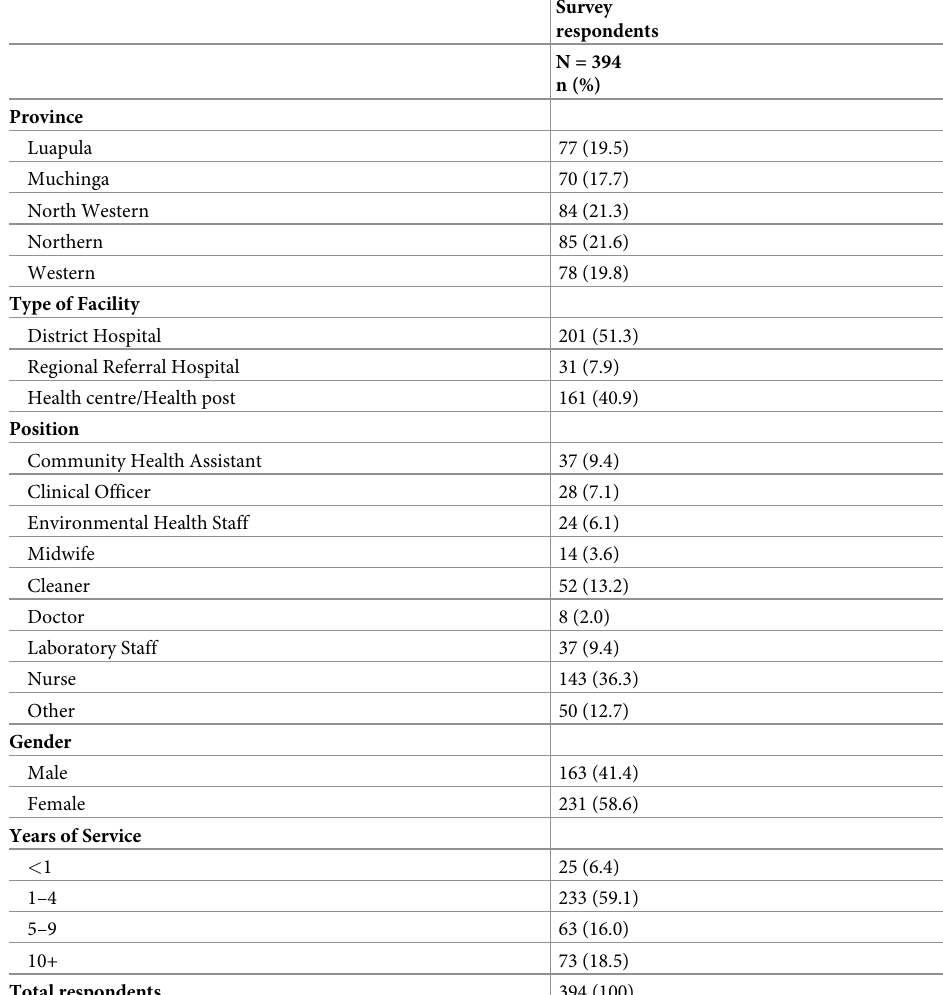
Table 1. Characteristics of the survey